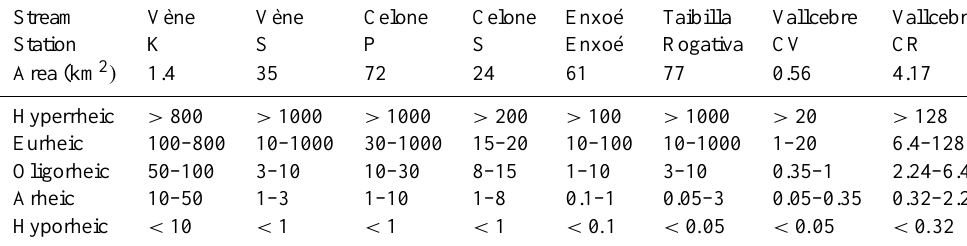
Table 4. Flow thresholds between aquatic states in ls − 1 defined in different streams studied in different basins of the MIRAGE project. Stream